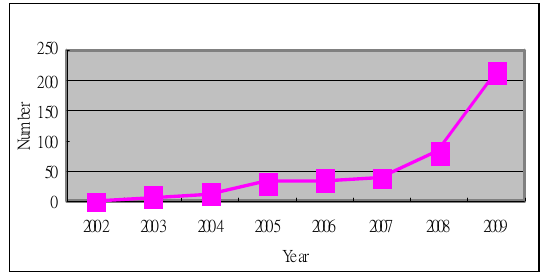
Figure 3. Complaints about light pollution in Hong Kong (Source: Environmental Protection Department of Hong Kong) Friends of the Earth (Hong Kong), stimulated by the complaints from the general public regarding lighting abuse, produced a light pollution map of Hong Kong (FoE, 2009). The general public, through the internet, can complain for specific black spots of heavily light polluted areas. After investigation, once the black spots have been confirmed, they are displayed on a